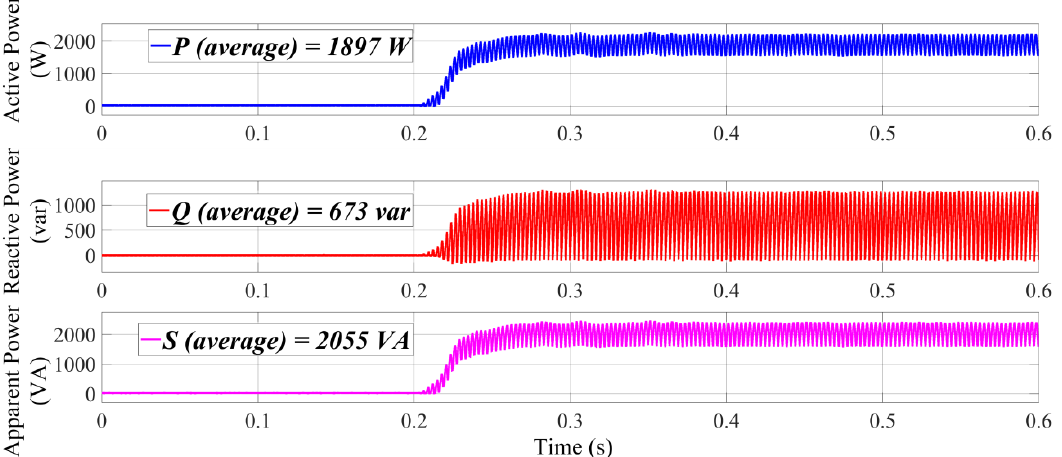
Figure 13. Active, reactive, and apparent power supplied by grid.